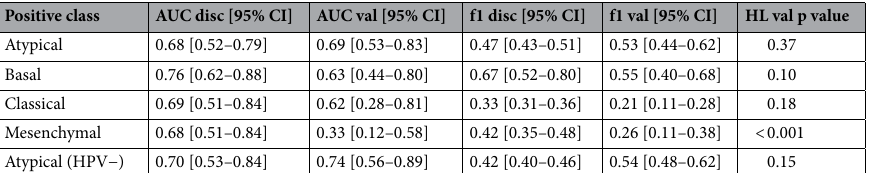
Table 2. Model performance for molecular subtype classification: median area under the curve (AUC) and f1 score in discovery (disc) and validation (val) cohorts with 95% confidence intervals (CI) alongside the p value for calibration using the Hosmer–Lemeshow (HL) test in validation. Abbreviations: HPV: human